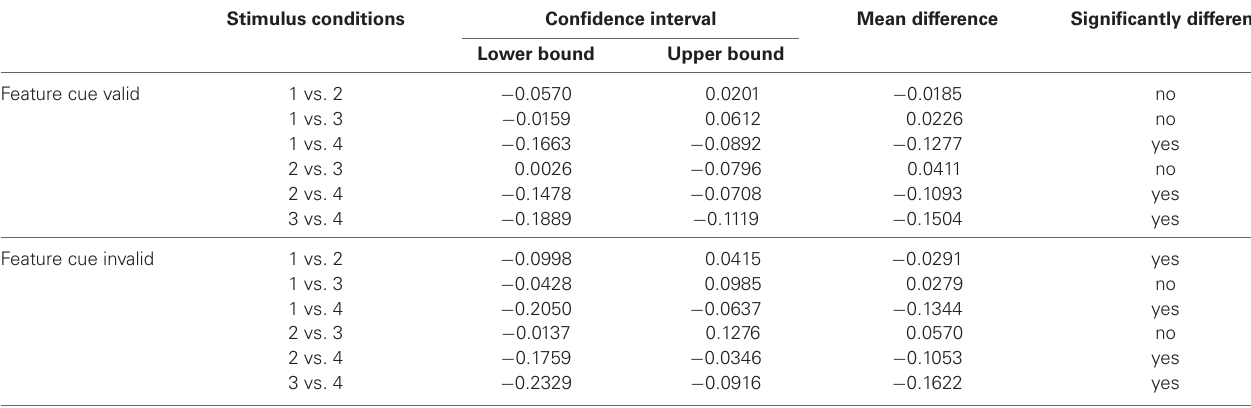
Table 2 | Statistical results for comparing change detection at the cued and uncued object, separately for object-defining and shared features, and depending on the feature cue being either validly (upper half) or invalidly (lower half) cued